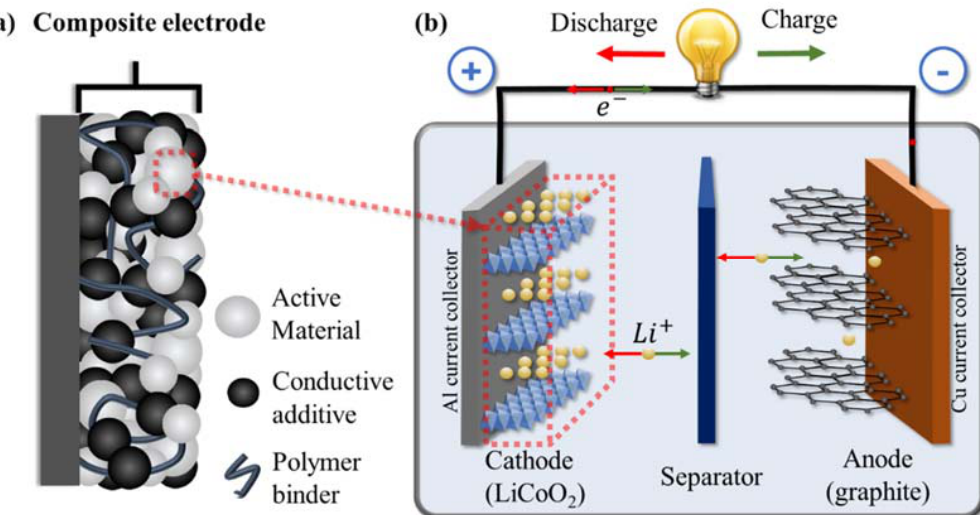
Figure 1. Schematic for ( a ) a composite electrode including the active material, conductive additive, and polymeric binder; ( b ) a full lithium-ion battery (LIB) with LiCoO 2 used as the active material for the cathode and graphite anode during discharge (with reactions shown occurring within a crystallite of active material).